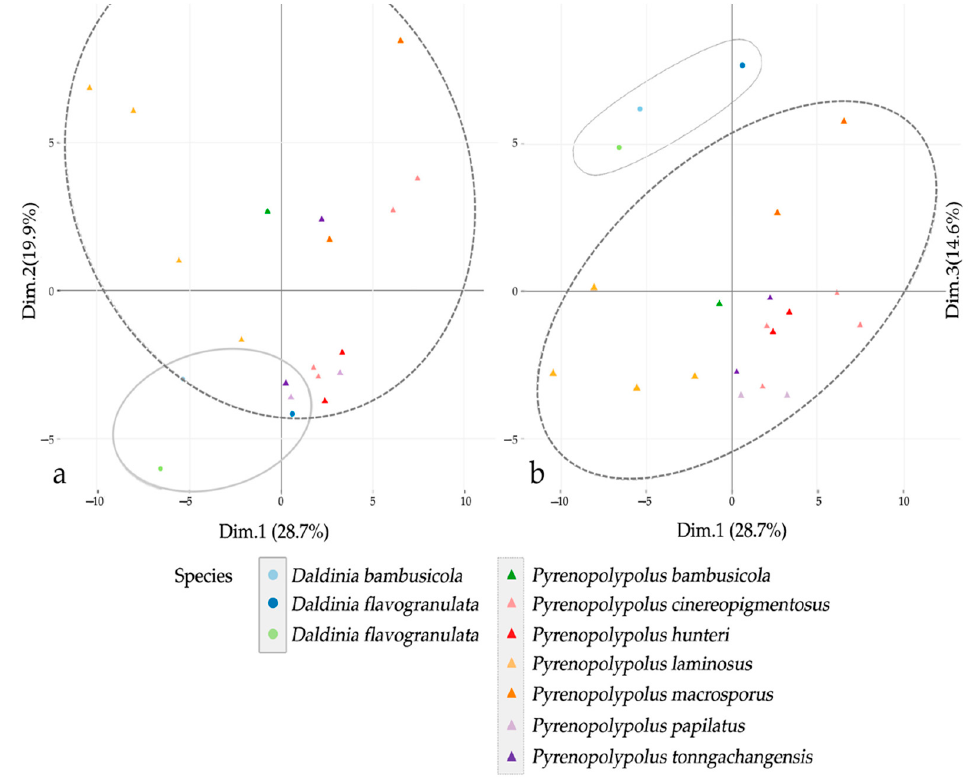
Figure 16. Principal component analysis (PCA) of denoised, recalibrated, and negative-control subtracted 82 MALDI-TOF mass spectra; ( a ) the coordinate plane between the first (Dim.1) and second (Dim.2) components; ( b ) the coordinate plane between the first (Dim.1) and the third components (Dim.3). The ovals on the fi gures represent 95% con fi dence concentration ellipses.